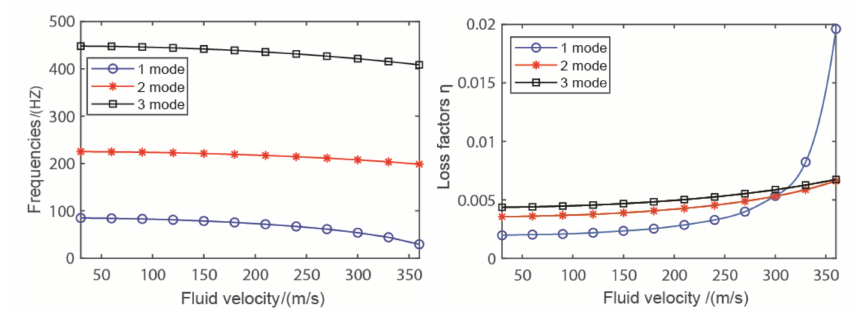
Figure 5. The influence of fluid